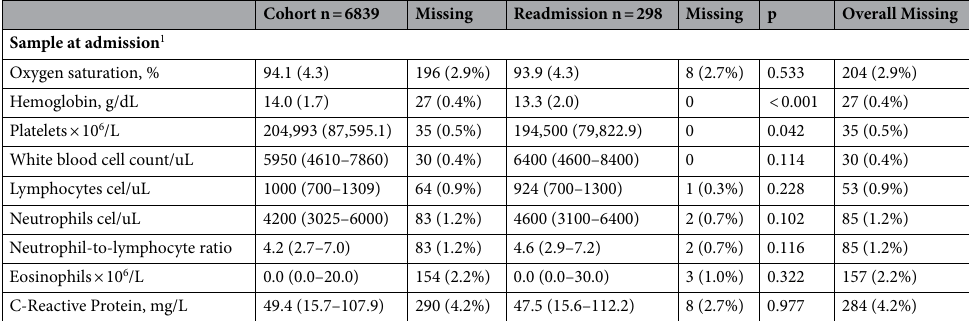
Table 4. Analytical results of patients with COVID-19 according to hospital readmission. 1 Sample at